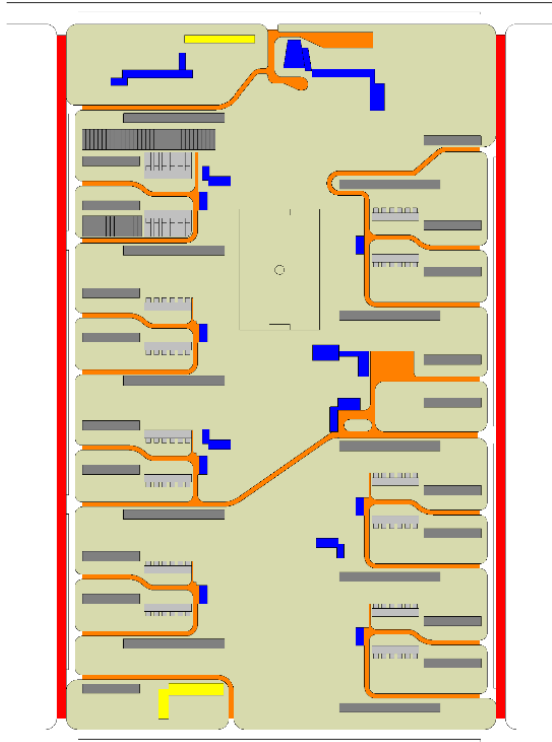
Figure 26. Formal structure, Port Tudor Satellite. Drawing by Manlio Michieletto. used by May in his East African spatial planning